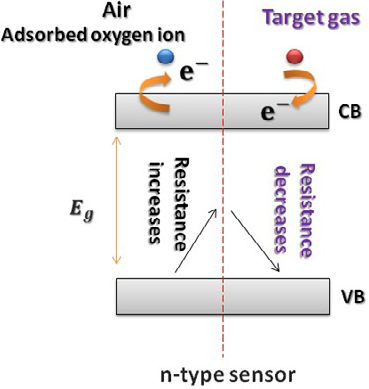
Fig. 7: Schematic diagram for changing the resistance of Fig. 7 sensor in the presence of the target